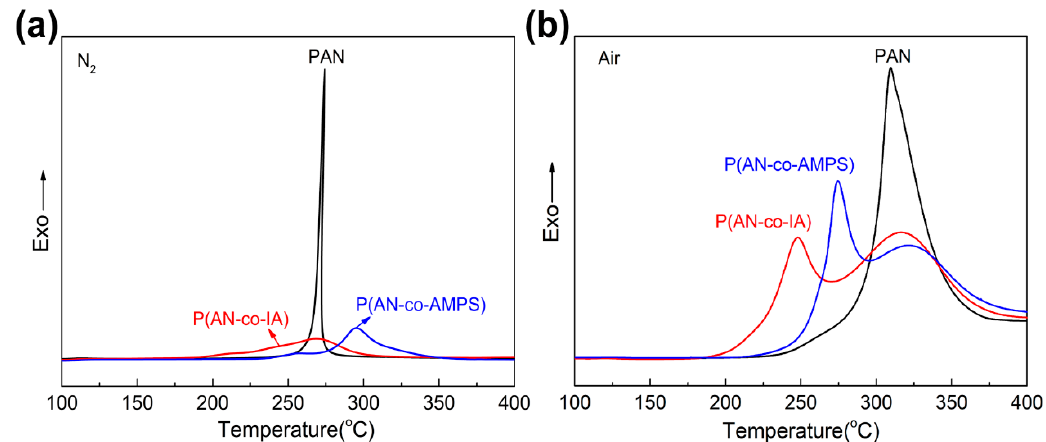
Figure 2. Representative scanning electron microscopy (SEM) images of ( a 1 – a 2 ) PAN, ( b 1 – b 2 ) P(AN- co-IA), and ( c 1 – c 2 ) P(AN-co-AMPS) nanofibers with different scales. ( a 3 ), ( b 3 ), and ( c 3 ) are diameter distribution histograms corresponding to PAN, P(AN-co-IA), and P(AN-co-AMPS) nanofibers, respectively.